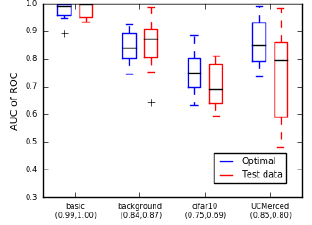
Figure 10. Performance with Config.3